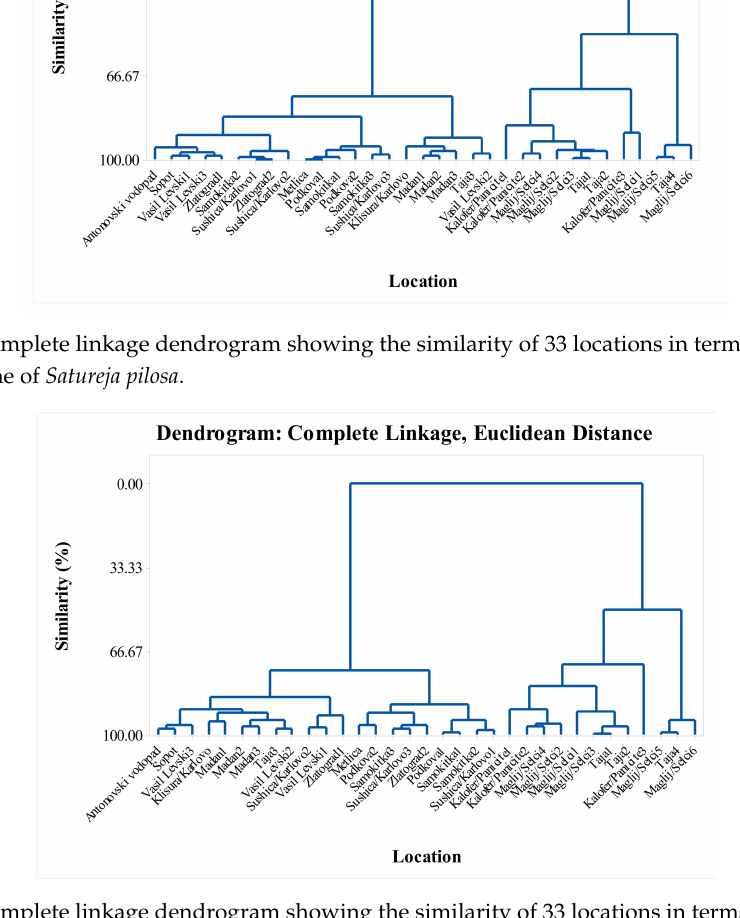
Figure 8. Complete linkage dendrogram showing the similarity of 33 locations in terms of carvacrol, p -cymene, and γ -terpinene of Satureja pilosa